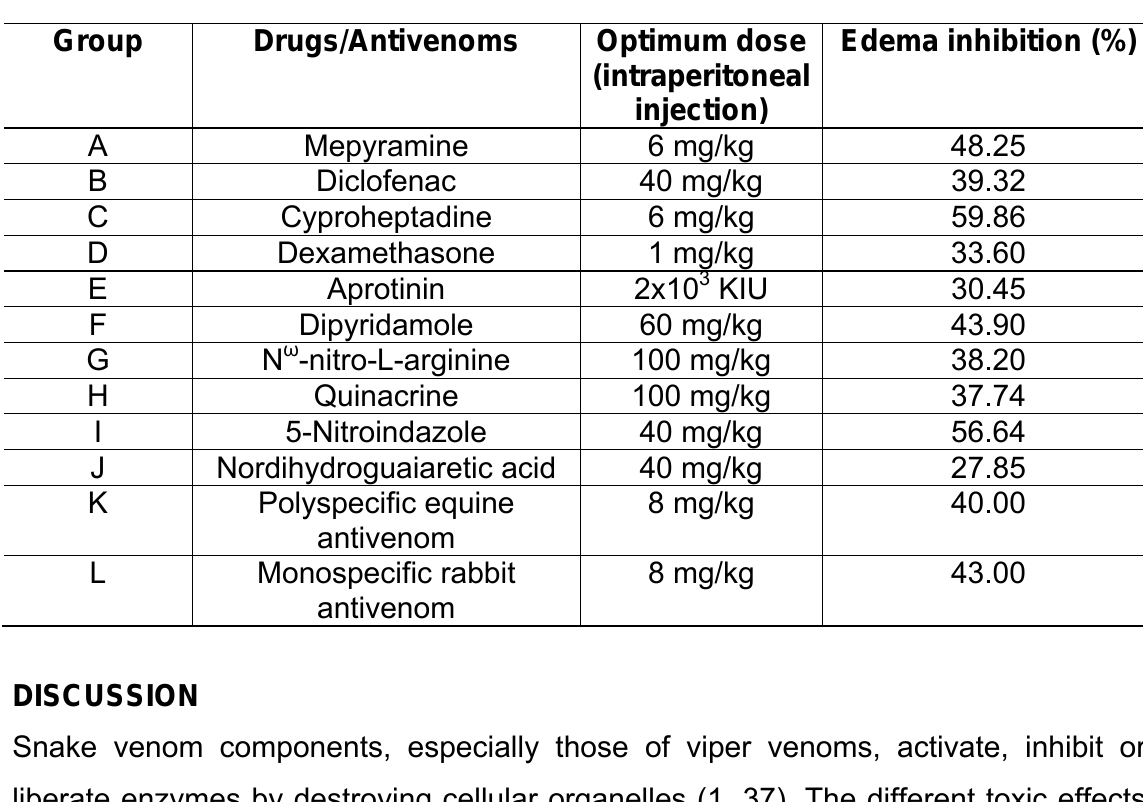
Table. 1. Inhibitory effect of drugs and antivenoms on rat paw edema induced by Cerastes gasperettii venom (120 µ